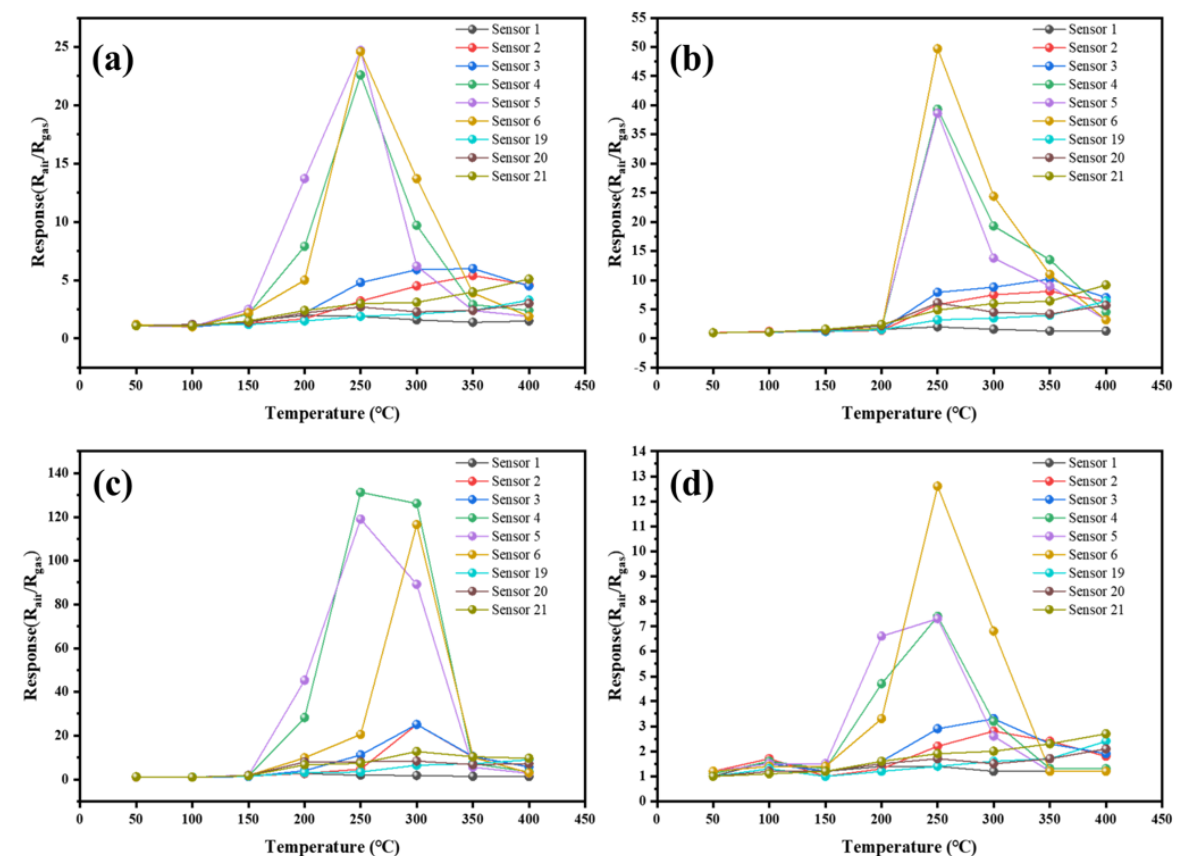
Figure 8. Response of nine gas sensors exposed to 100 ppm of four gases at different operating temperatures, ( a ) benzene, ( b ) toluene, ( c ) xylene, and ( d ) formaldehyde.